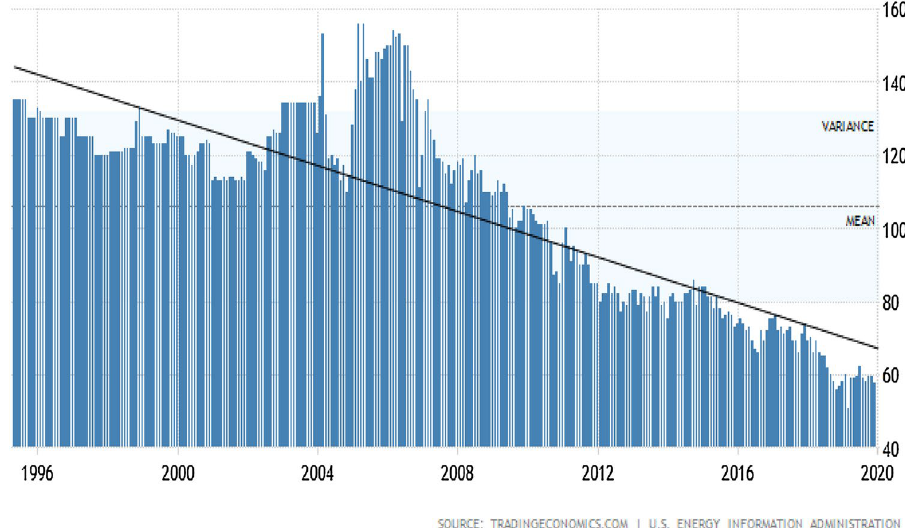
Fig. 1 Crude oil production data from Trinidad and Tobago by year from 1994 to 2019 (https ://tradi ngeco nomic s.com/trini dad-and-tobag o/crude -oil-produ ction